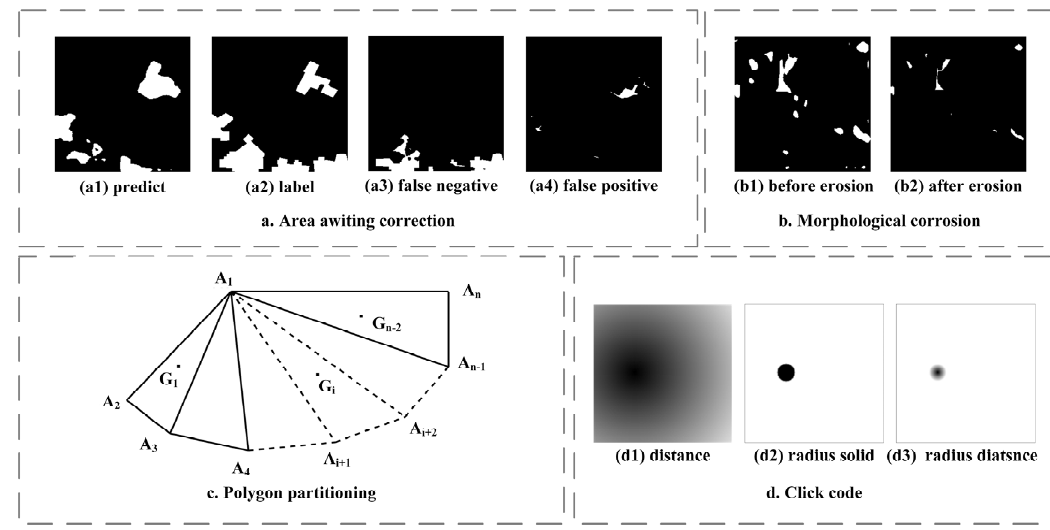
Figure 4. Schematic diagram of the click generation algorithm.